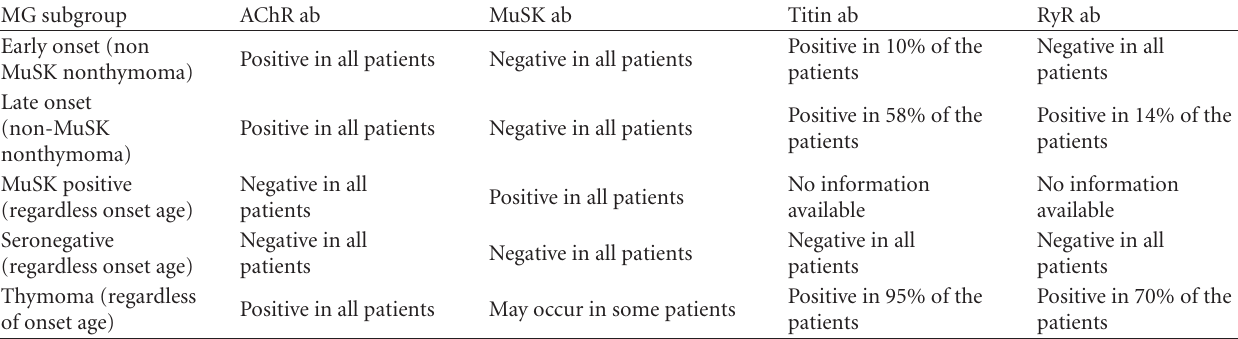
Table 1: The occurrence of the various muscle autoantibodies (ab) in the di ff erent subgroups of MG